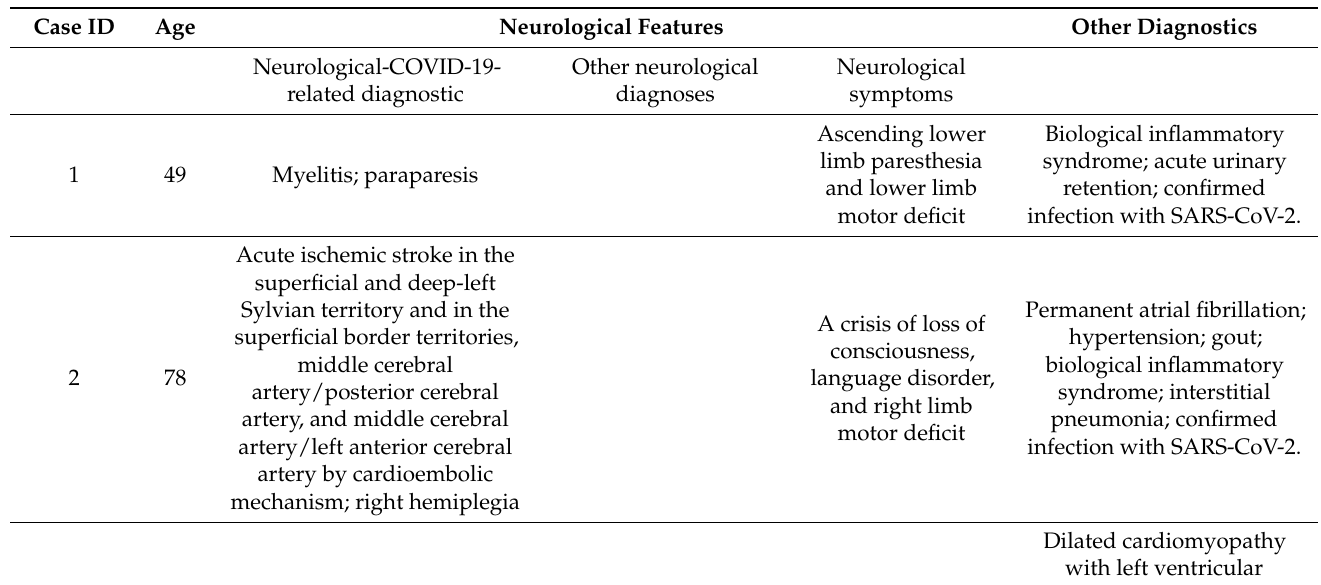
Table 2. Baseline and clinical characteristics of COVID-19 patients with neurological